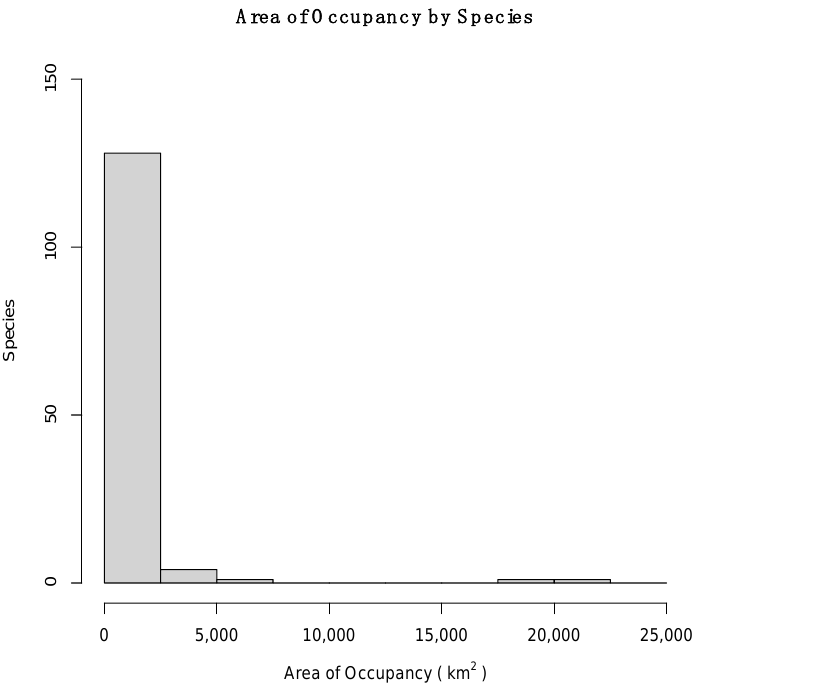
Figure 3. The frequency distribution of introduced and naturalized or breeding species of parrots (Psittaciformes) by their AOO (Area of Occupancy). The AOO only refers to introduced populations.